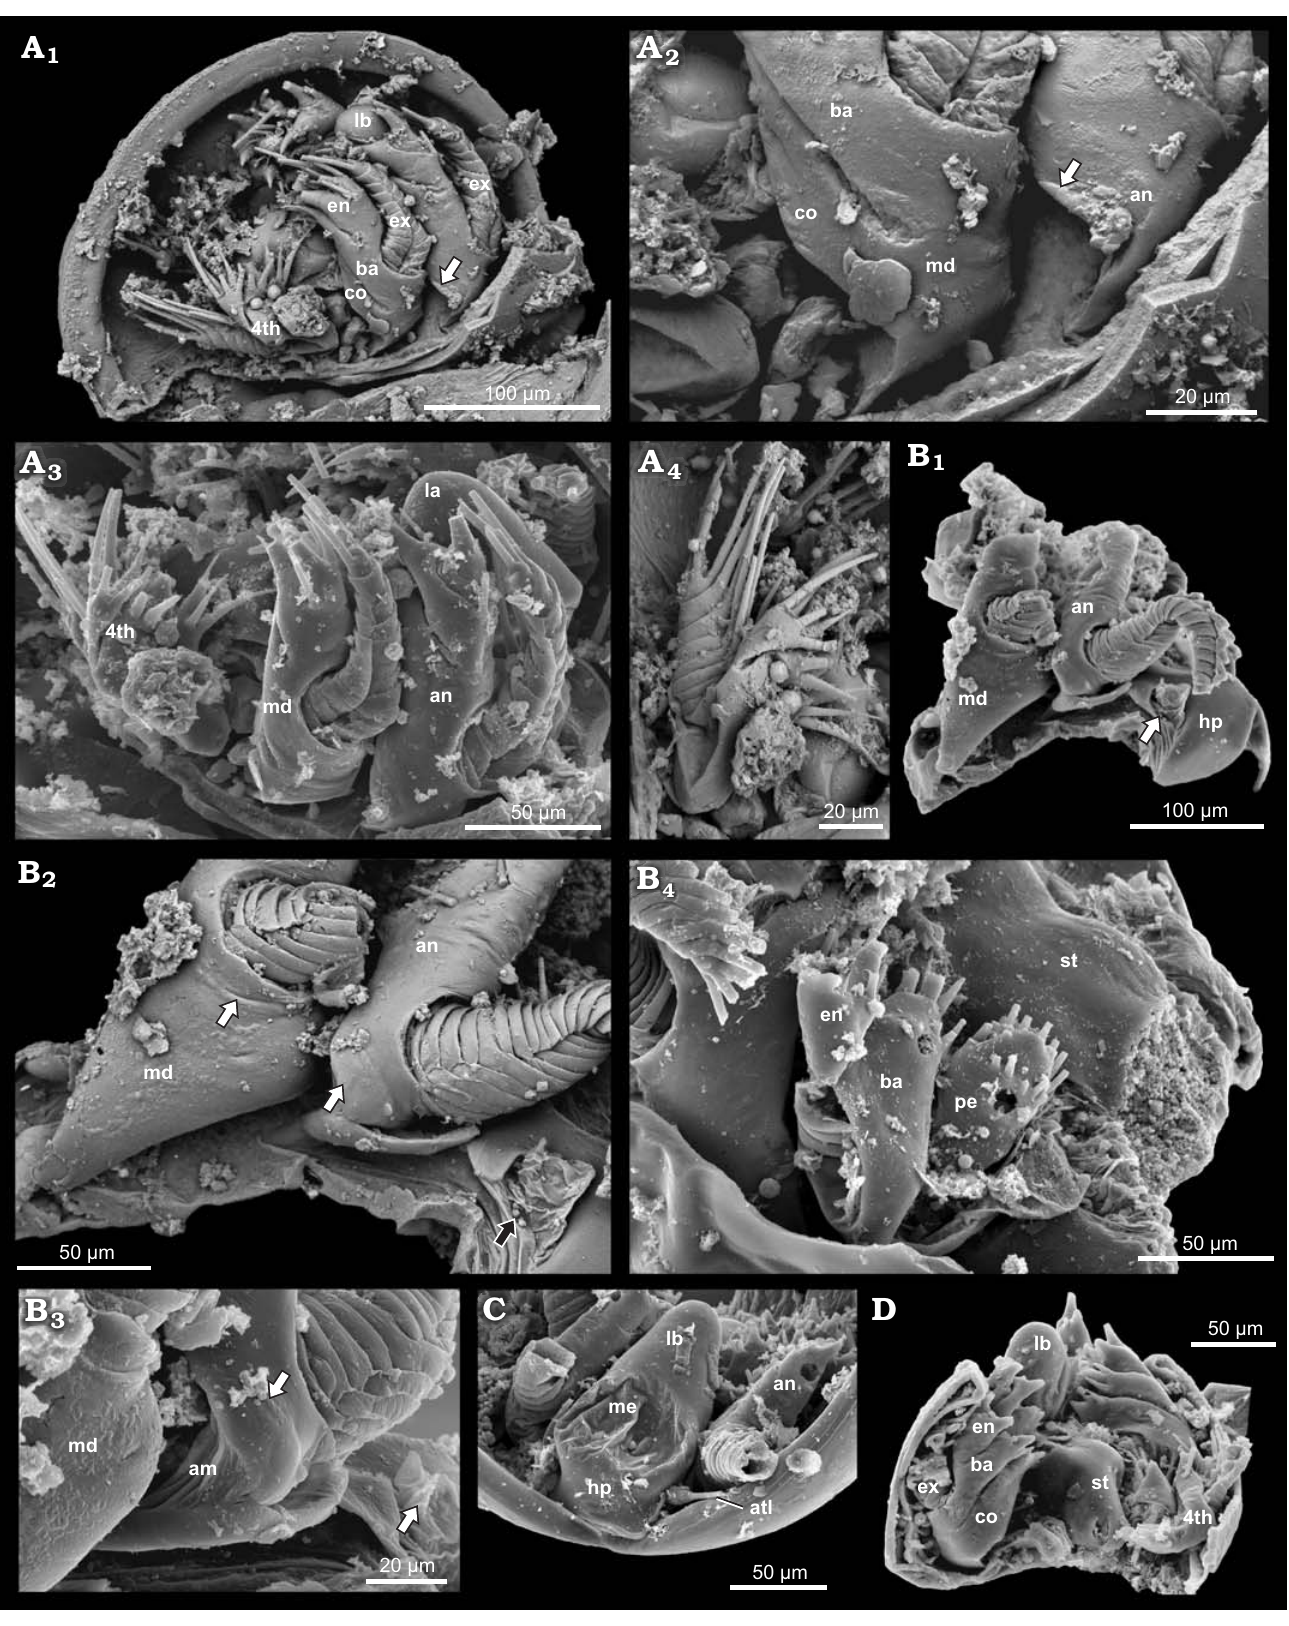
Fig. 8. Examples of phosphatocopids with soft parts preserved from the Olenus Biozone, Furongian, D ę bki 2 borehole, northern Poland. A . ZPAL Cr.11/ ph414, head larvae stage of Hesslandona unisulcata Müller, 1982, ventral is up; BSE image, lateral view of right side exhibiting antenna, mandible and first post-mandibular limb, small triangle-like cuticular structure at base of antenna (arrow) (A 1 ); BSE image, detailed view of proximal part of antenna,